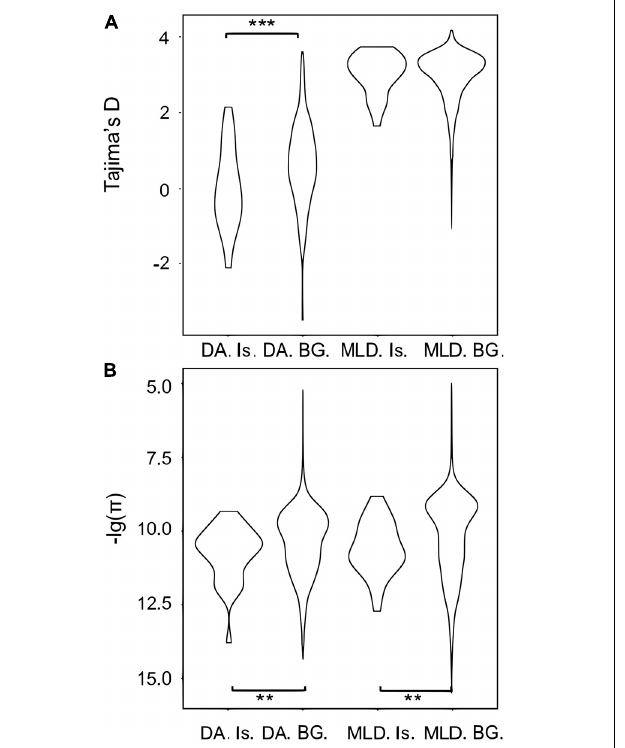
FIGURE 3 | Violin plots for (A) Tajima’s D and (B) genetic diversity ( π ) in the Hainan and continental populations in differentiated islands (Is.) and the background (BG.). DA and MLD represent Hainan and the merged continental populations, respectively. Significant results of t -test are represented by asterisks (**0.01 < p < 0.05; *** p < 0.01).